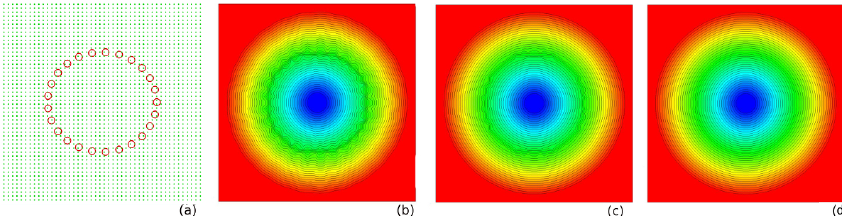
= π resolution ratio where ∆ X is the mesh (resp. interface) space X ∆ L π ; ( d ) π ] (cylinder ∆ X = [( b ) π ; ( c ) 2 4